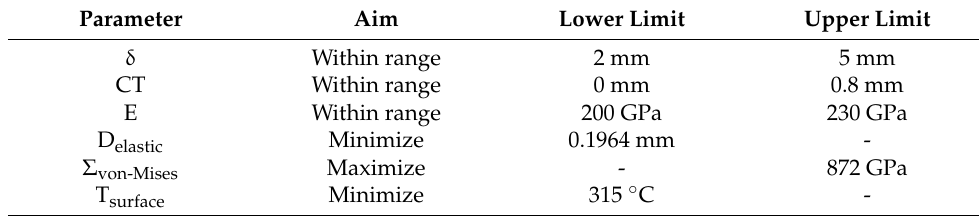
Figure 18. Comparative analysis of maximum NO x and HC (response to Blend-BMEP). Table 7. Optimum process parameters.